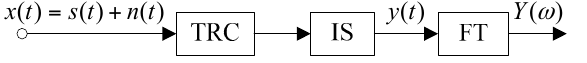
Figure 6. Block diagram of time reversal convolution and interference suppression (TRC-IS).